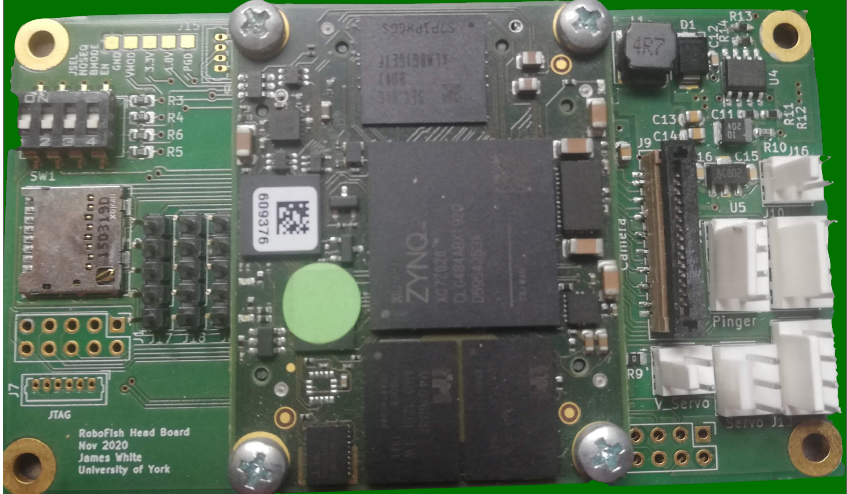
Figure 10. RoboFish Head Carrier PCB with the TE0720